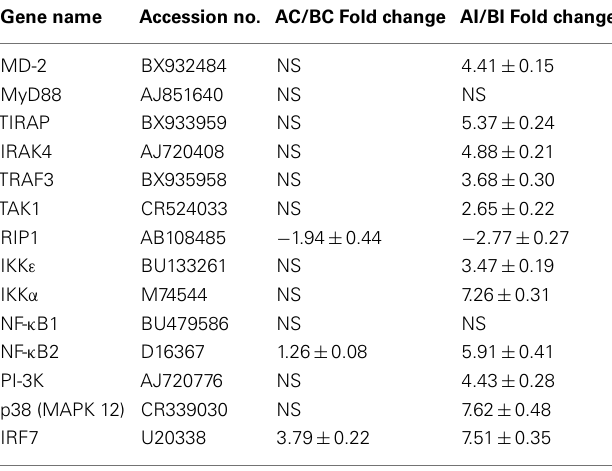
Table 5 | Fold change ofToll-like receptor pathway genes between heterophils isolated from lineA and B chickens using qRT-PCR